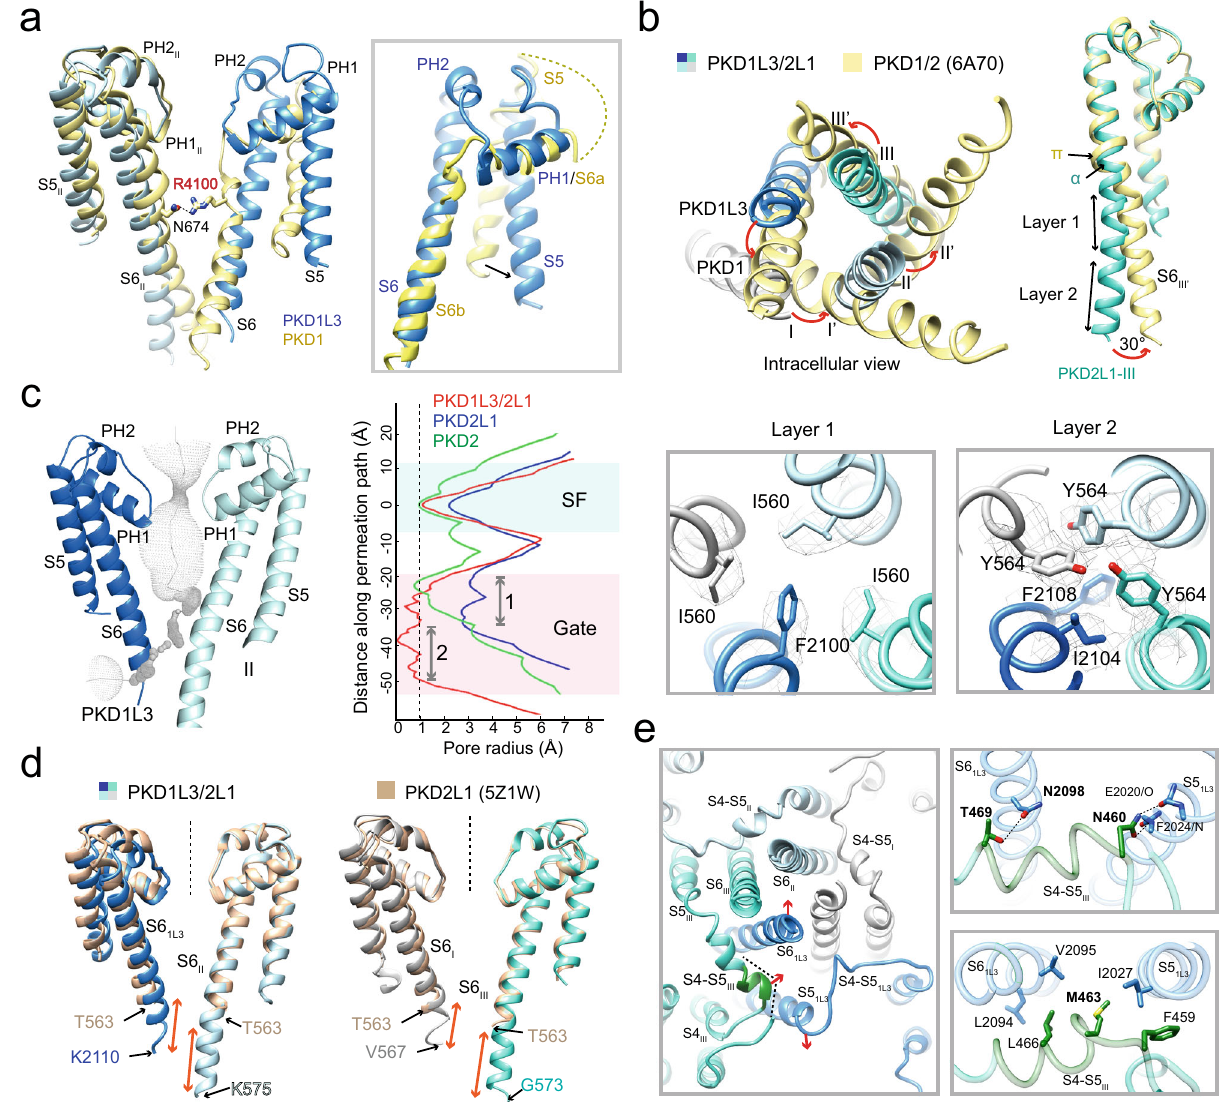
Fig. 2 A closed pore with an elongated intracellular gate. a Difference in the architecture of PD between PKD1L3/2L1 and PKD1/2 (PDB code: 6A70). PKD1L3 has a conventional PH1-SF-PH2 segment that is missing in PKD1 34 . Inset: Comparison of the PD segments of PKD1 (yellow) and PKD1L3 (blue). The S6 segment of PKD1 bends in the middle, resulting in a S6a half helix that aligns with a typical pore helix PH1. The sequence connecting S6a and S5 is invisible in PKD1. b Conformational shifts between the S6 tetrahelical bundles of PKD1L3/2L1 and PKD1/2. The PD of apo PKD1L3/2L1 is superimposed with that of PKD1/2. A secondary structural element transition in the middle of S6 from an α helical turn in PKD2L1 to a π helix in PKD2 results in an iris-like rotation of the S6 tetrahelical bundle. The conformational shifts of the corresponding segments from PKD1L3/2L1 to PKD1/2 are indicated by red arrows. c The PD is sealed by an elongated intracellular gate. The permeation path of the apo heterotetramer, calculated by HOLE 69 , is illustrated by gray dots. The pore radii of PKD1L3/2L1 (red), homotetrameric PKD2L1 (blue, PDB code: 5Z1W), and homotetrameric PKD2 (green, PDB code: 5T4D) are compared (right). The intracellular gate of PKD1L3/2L1 is extraordinarily elongated and will be illustrated as two layers. Right two panels: Composition of the two layers of the intracellular gate. Shown here are extracellular views. The densities are contoured at 5 σ . d PD comparison between PKD1L3/2L1 and PKD2L1 homotetramer. Longer S6 segments of PKD2L1 were resolved in PKD1L3/2L1 than those in the PKD2L1 homotetramer. Note that the PKD2L1 subunits exhibit nearly identical conformations in the two channels. e Structural deviations of the S4 – S5 linkers of the four subunits in PKD1L3/2L1. Left: Whereas the linkers between S4 and S5 in PKD2L1, similar to those in other VGIC proteins, forms a short helix, that in PKD1L3 is a loop. Even among the three PKD2L1 subunits, the S4 – S5 linker in VSD III is distinct from the other two. The C-terminal short helix (dark green) of the S4 – S5 III bends toward the PD, pushing S6 of PKD1L3 inward. Right: The S4 – S5 helix of PKD2L1-III interacts with the S5 and S6 helices of PKD1L3 through speci fi c hydrogen bonds (upper panel) and extensive van der Waals contacts (lower panel). The hydrogen bonds are indicated by black dashed